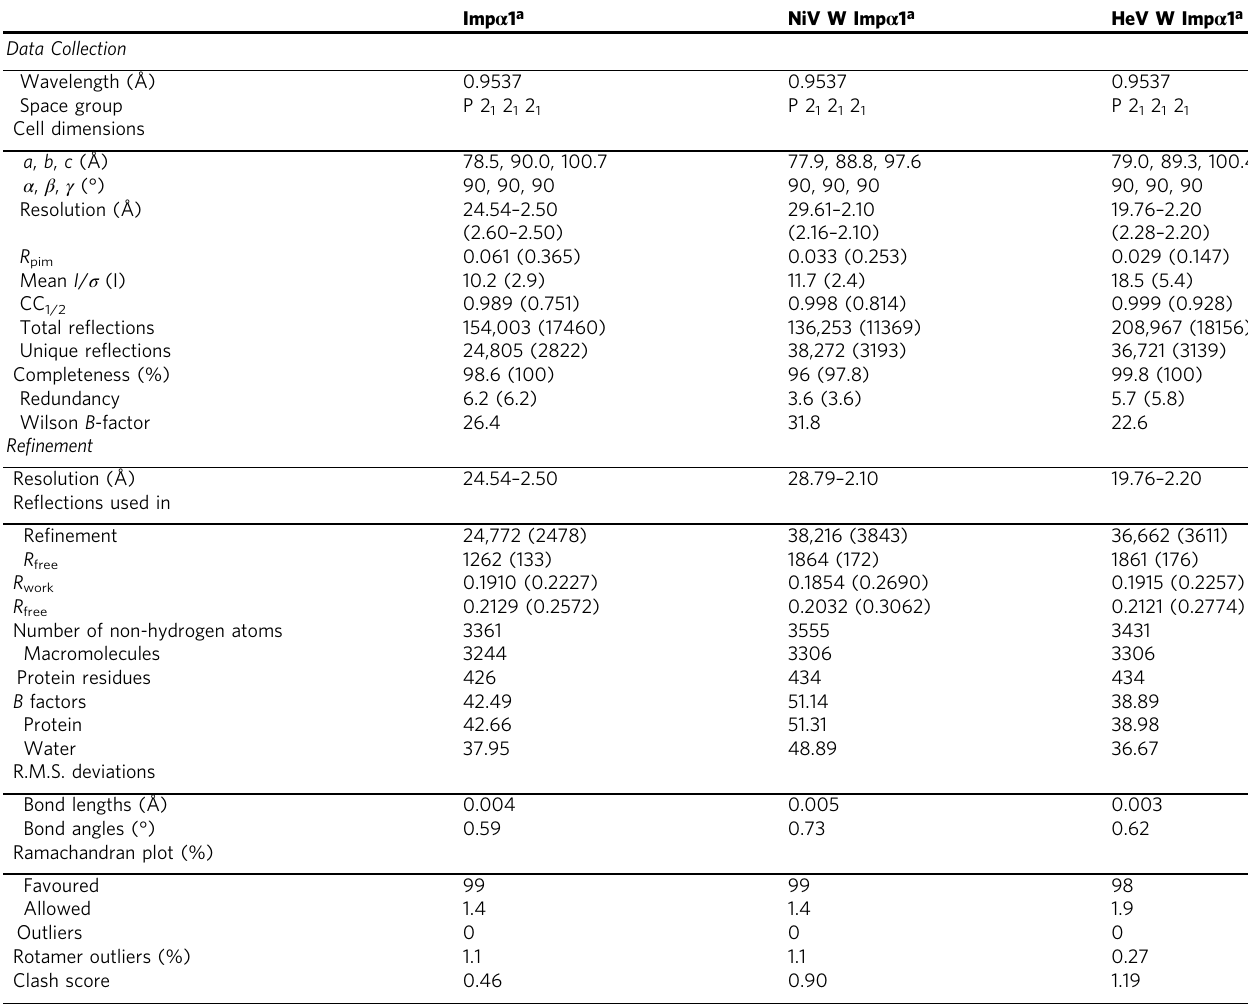
Table 1 Data collection and re fi nement statistics for importin α 1